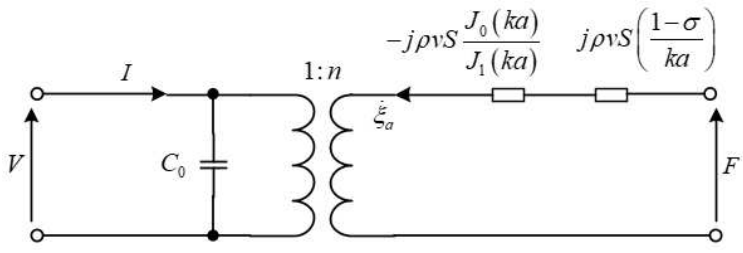
Figure 2. Electromechanical equivalent diagram of single